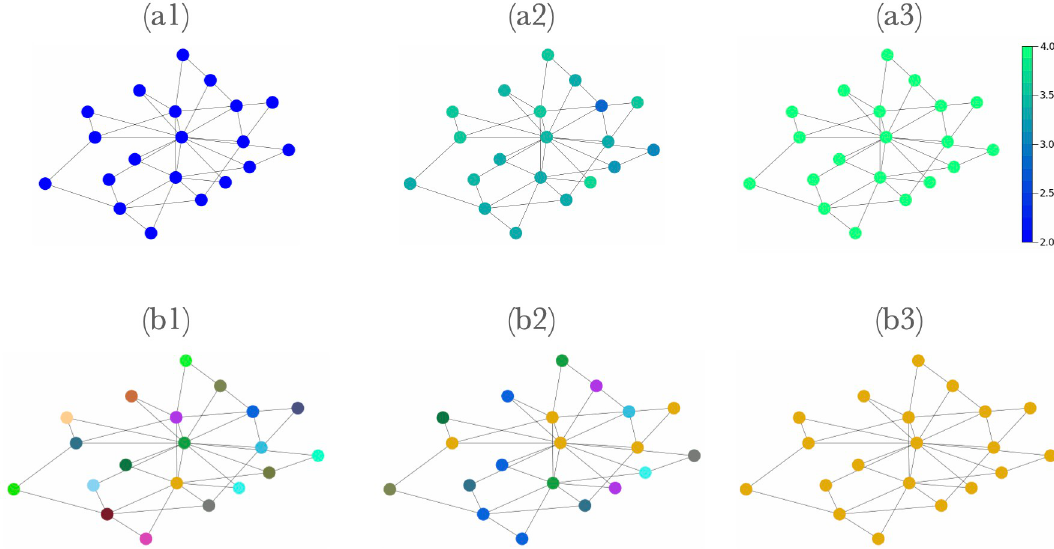
Fig 1. Illustration of the convergence dynamics towards a common language. Each node represents a single agent, and is colored (a) based on the agent’s payoff, with a lighter color implying higher payoff, and (b) based on agents’ languages, with each color representing a distinct language. In the initial generation, all agents are assigned different, randomly generated languages (b1) that are not well-suited for collective communication (a1). Correspondingly, payoffs are similar and low. As the simulation progresses, some languages are adopted by multiple agents (b2), and all languages become more alike, yielding higher payoffs (a2). By the end, all agents adopt the same language (b3), and the payoff of communication is the maximum possible given that language (a3). (Colors between (a) and (b) are not